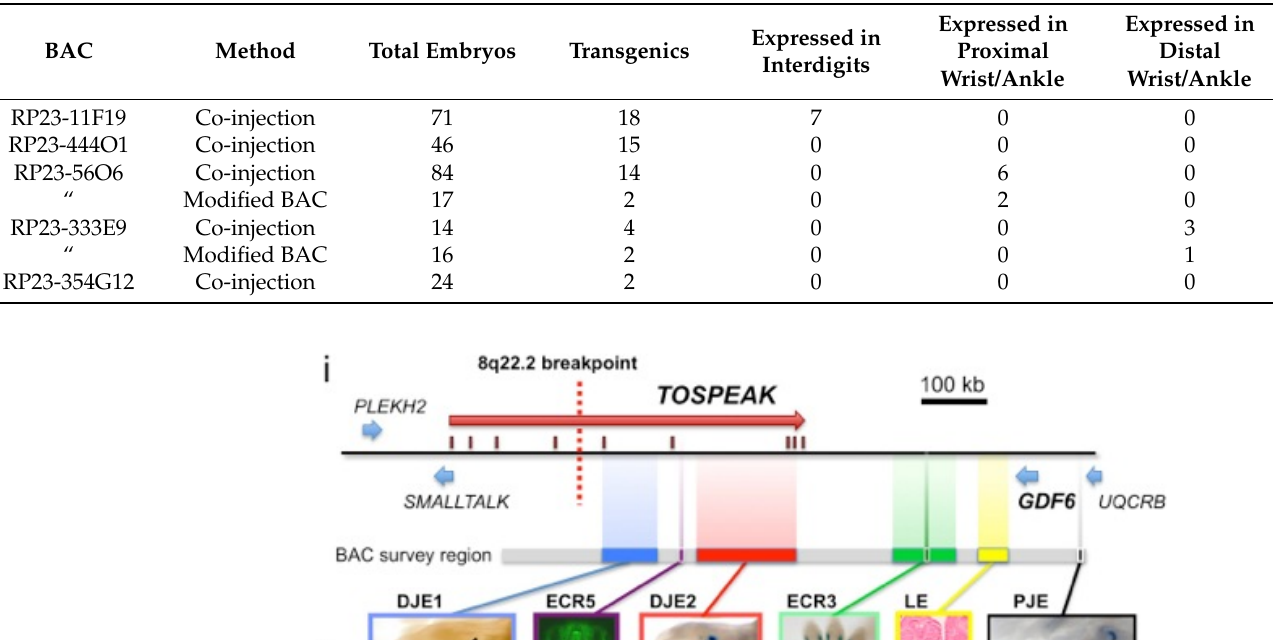
Table 2. BAC Injections into mouse embryos to generate transgenic embryos.